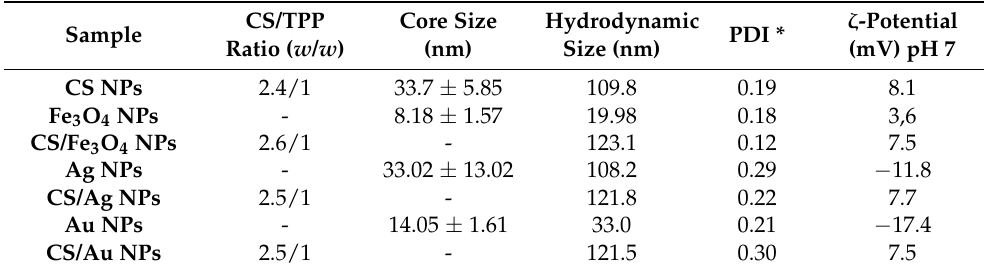
Table 1. Optimization study of ionotropic gelation-based synthesis of CS and CS-based hybrid NPs and their representative characterizations.